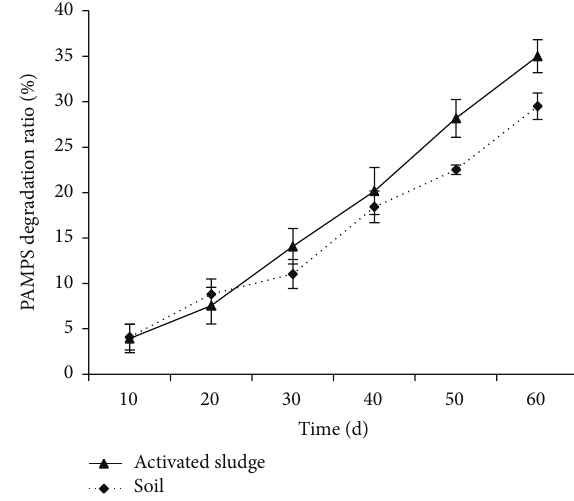
Figure 4: Water retention kinetics of F8 PAMPS polymer at 25 ∘ C. Error bars represent ± S.E. For additional explanations, see Figure 3.